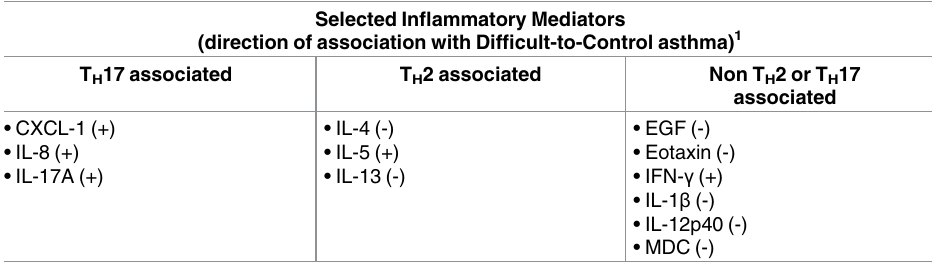
Table 4. Inflammatory mediators associated with asthma control based on multivariate feature